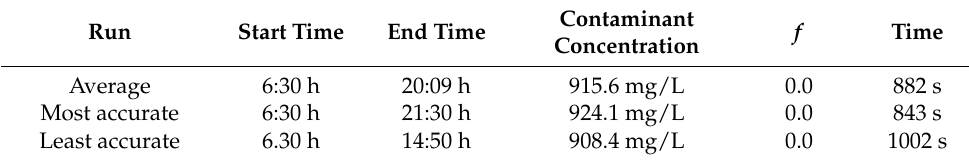
Table 7. Framework 1 results for the Richmond network for the source node